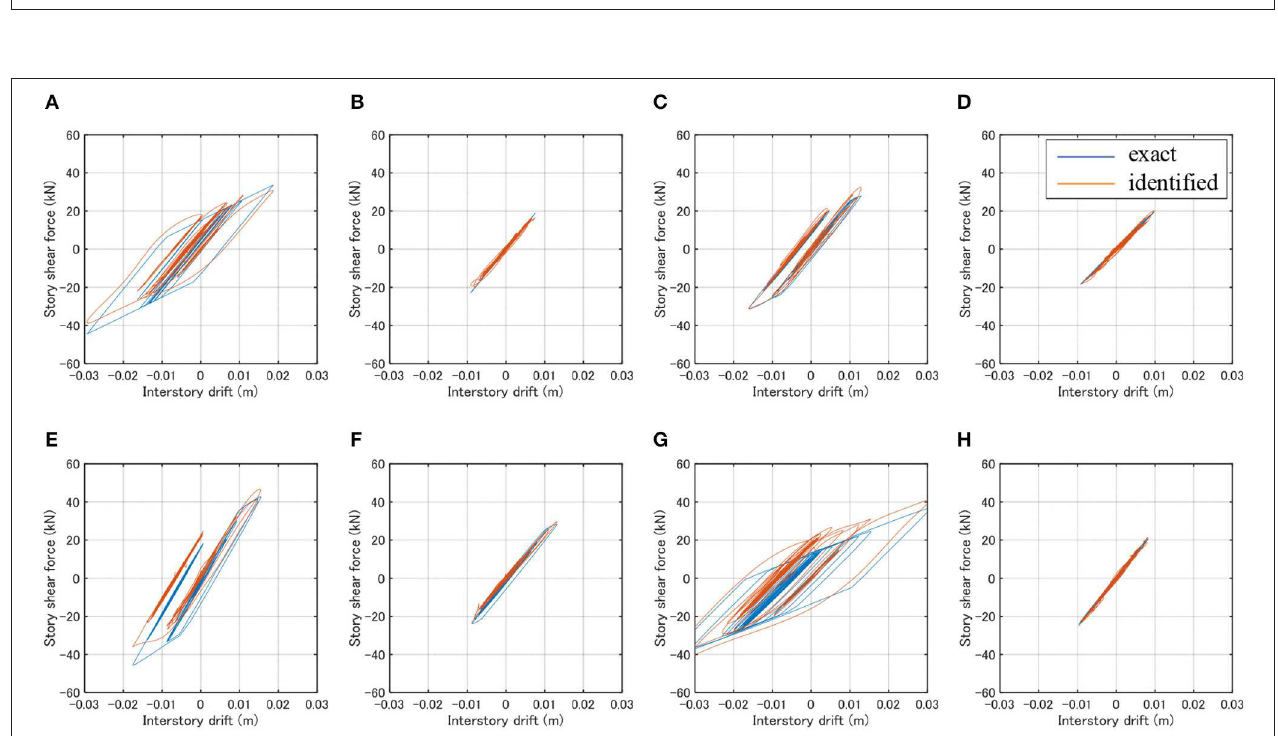
FIGURE 9 | Identification results (Kobe Univ. NS). (A) V-frame (x1_1F). (B) V-frame (x1_2F). (C) V-frame (x3_1F). (D) V-frame (x3_2F). (E) V-frame (y1_1F). (F) V-frame (y1_2F). (G) V-frame (y3_1F). (H) V-frame (y3_2F).